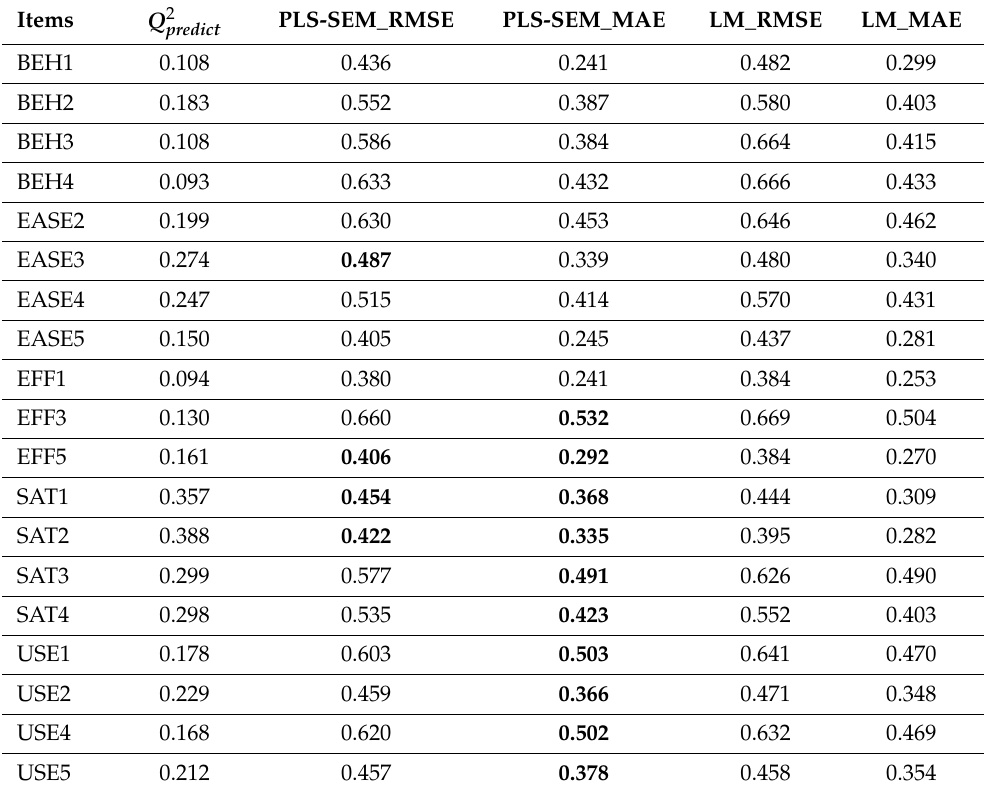
Table 9. Results of testing the predictive power of the research